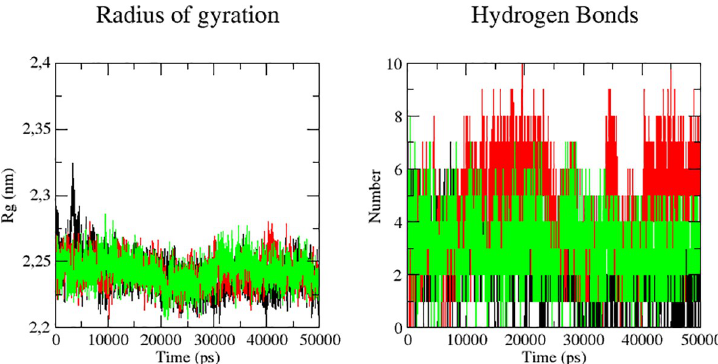
Fig 7. Rg and hydrogen bonds plots for Mpro complex with quercetin -3 rhamnose (black), myricetin 3-rutinoside (red) and rutine (green) for 50